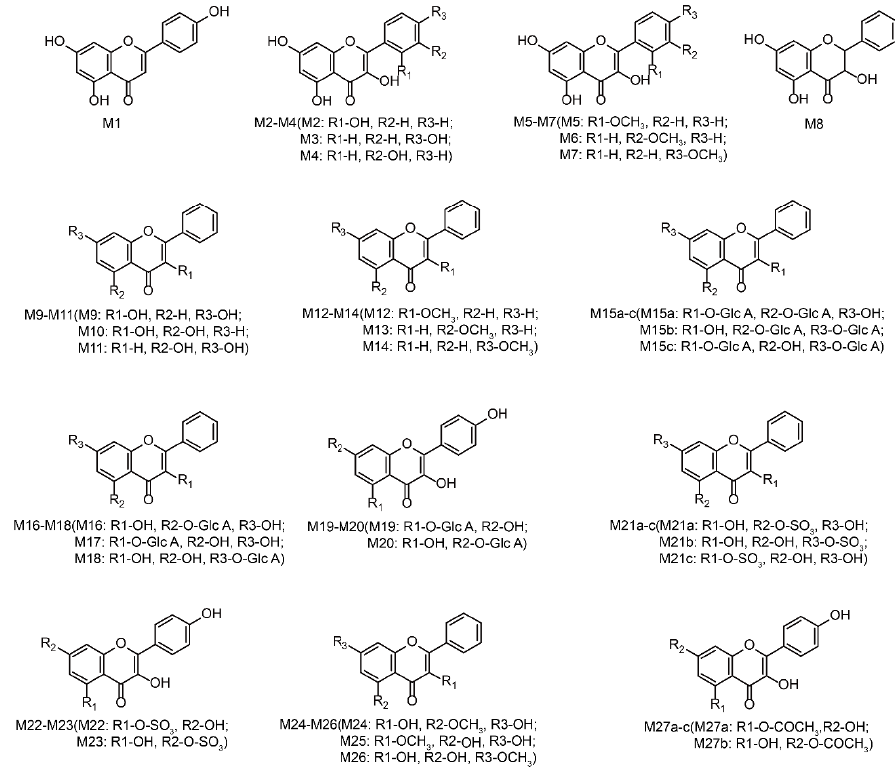
Figure 5. Chemical structures of all metabolites of galangin in in vitro and in vivo experiments (a, b, and c: possible chemical structure).